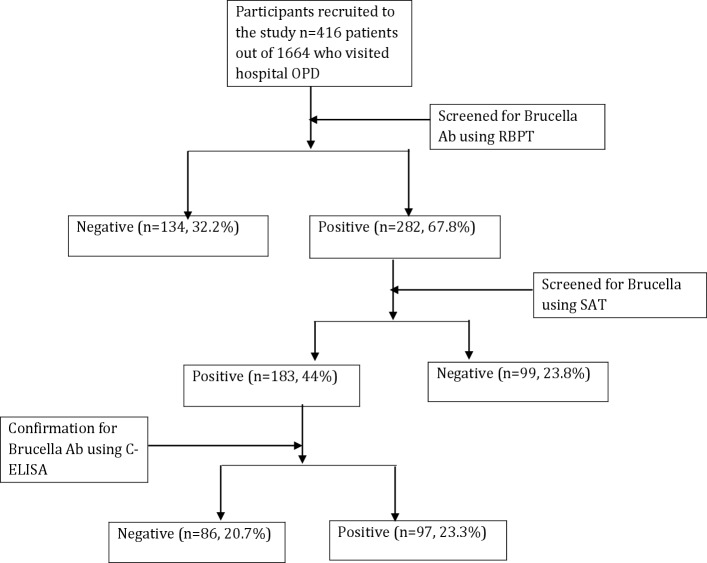
Summary of the outcomes of patient recruitment in the study.